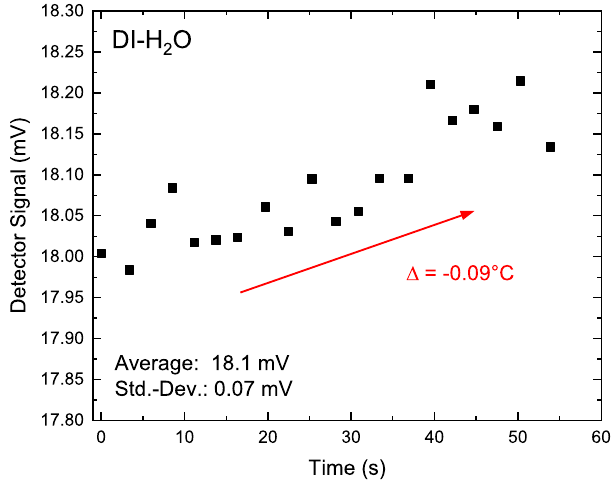
Fig. 7 | Submersion experiment in native biophysical conditions, i.e., water. Detector Signal when operating the QCLD sensor in DI-H 2 O for about 1min and increasing the temperature by about 0.1 ∘